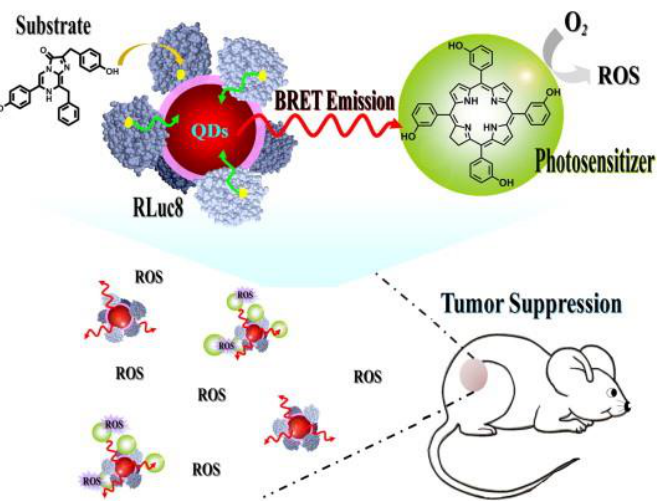
Figure 8. Schematic representation of RLuc8-immobilized QDs-655 for BRET-based PDT. Reproduced with permission from C.-Y. Hsu et al., Biomaterials; published by Elsevier, 2013 [234].